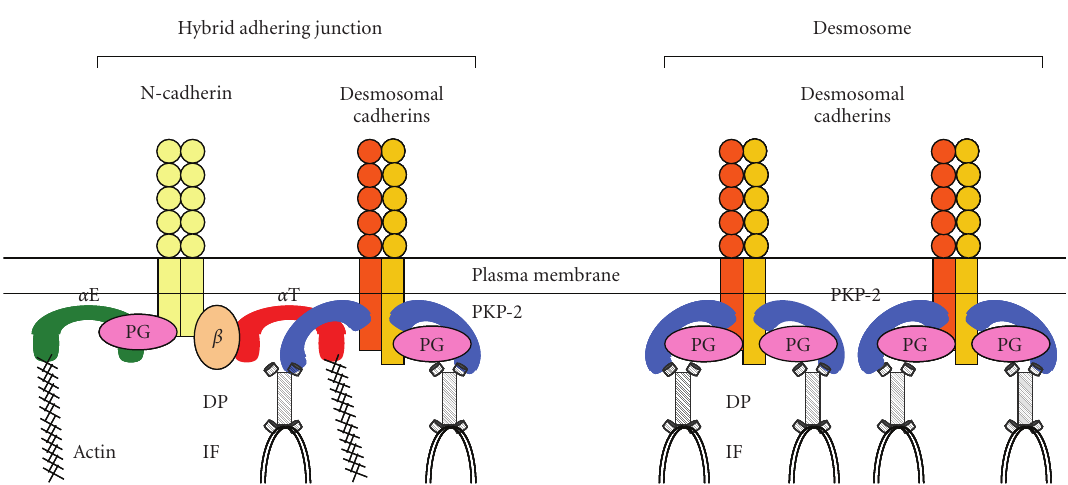
Figure 2: Model for cadherin-based area composita in the heart. α T-catenin recruits desmosomal protein, plakophilin- (PKP-) 2 to hybrid adhering junction (left drawing), thereby forming, together with desmosome (right drawing), an area composita, which is an enforced, mixed-type junctional structure attached to both the actin cytoskeleton and the intermediate filament (PG: plakoglobin; DP: desmoplakin).